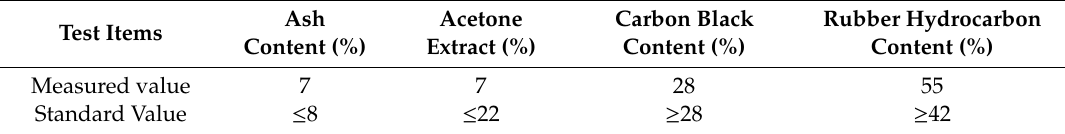
Table 3. Chemical properties of crumb rubber.